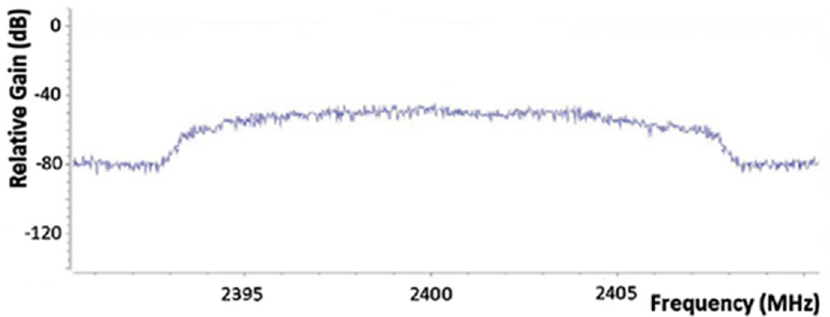
Figure 4. Barrage Jamming Spectrum.